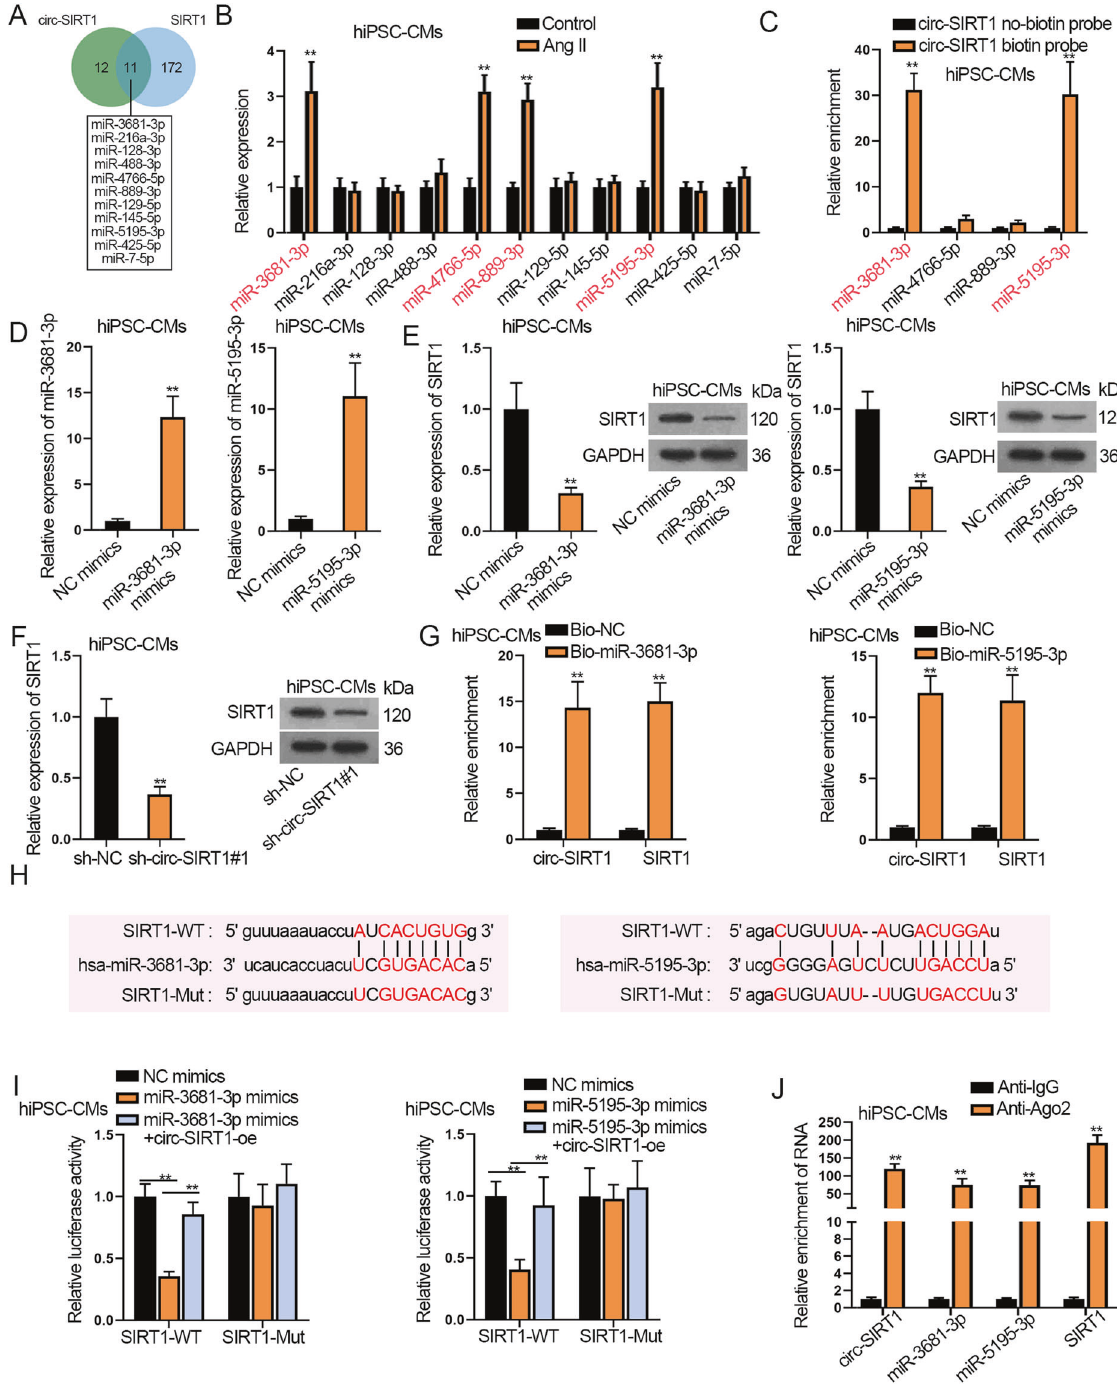
3-MA treatment reversed the promoting effect of circ-SIRT1 overexpression on LC3-II/LC3-I and LAMP1 protein levels and Also, we evaluated the extent of autophagic fl ux. The